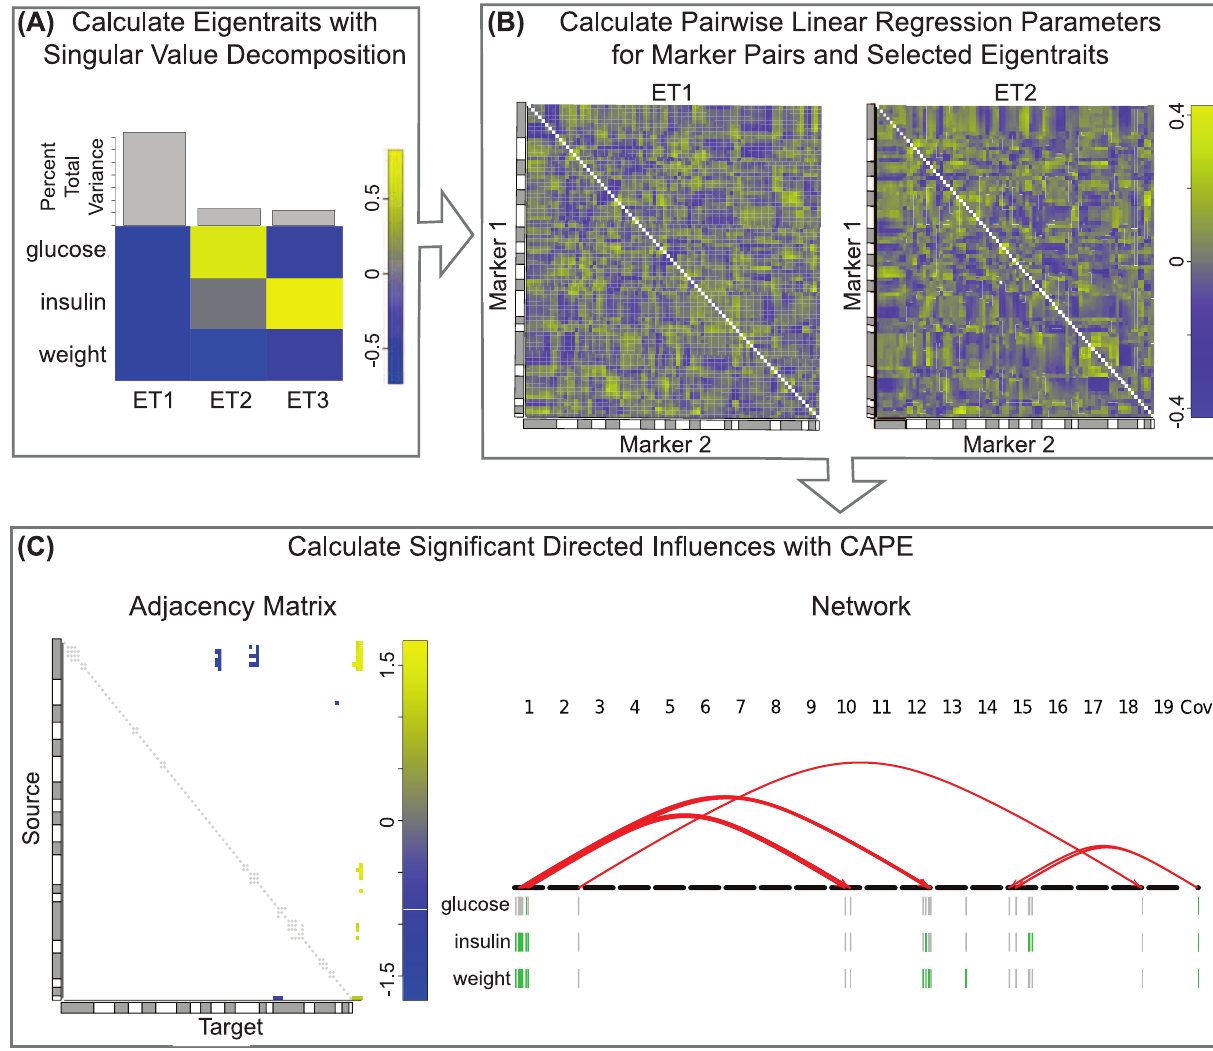
Figure 2. Overview of R/cape workflow and visualization tools using example data [ 1 ] . (A) Phenotypes are first decomposed into orthogonal eigentraits (ETs). Phenotype composition and global variance fraction are displayed for each ET, facilitating the selection of ETs for interaction analysis. In this study, the first two ETs were selected, which contained the correlated signal between all phenotypes and a divergence between phenotypes, respectively. (B) Pair-wise linear regression is next performed on each ET. Symmetric matrices of all marker pair interaction terms are displayed in matrix form, with gray and white bars along the axes to mark chromosome boundaries. The first two ETs for this study are shown. (C) Regression parameters are next reparametrized (Figure 1) to derive models of directed interactions between markers and from markers to phenotypes. In the adjacency matrix view (left), markers are designated as sources or targets of directed interactions, and marker-to-phenotype influences are in the rightmost columns. Only variants with significant main effect or interaction are shown, and gray dots mark pairs that were not included in the model due to linkage disequilibrium. In the network view (right), arrows are directed from source to target marker positions across all chromosomes. Red arrows indicate suppressive (negative) interactions. Main effects are represented below the variants with green indicating an effect that increases phenotype and gray indicating no significant main effect on phenotype.